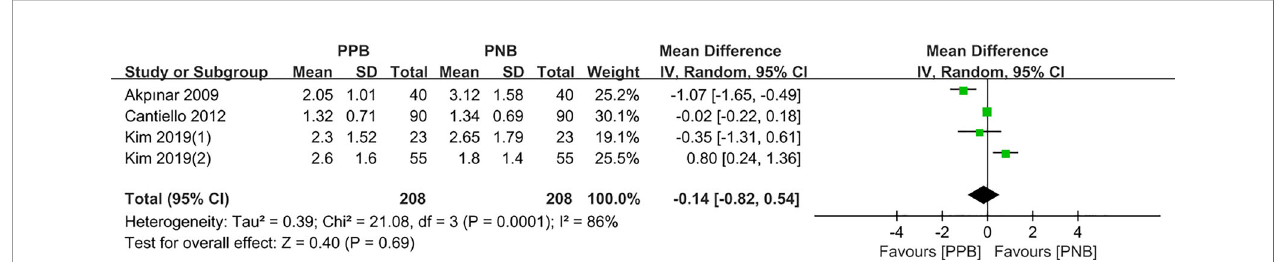
FIGURE 3 | Forest plot comparing VAS score-local anesthetic injection in patients receiving PPB vs